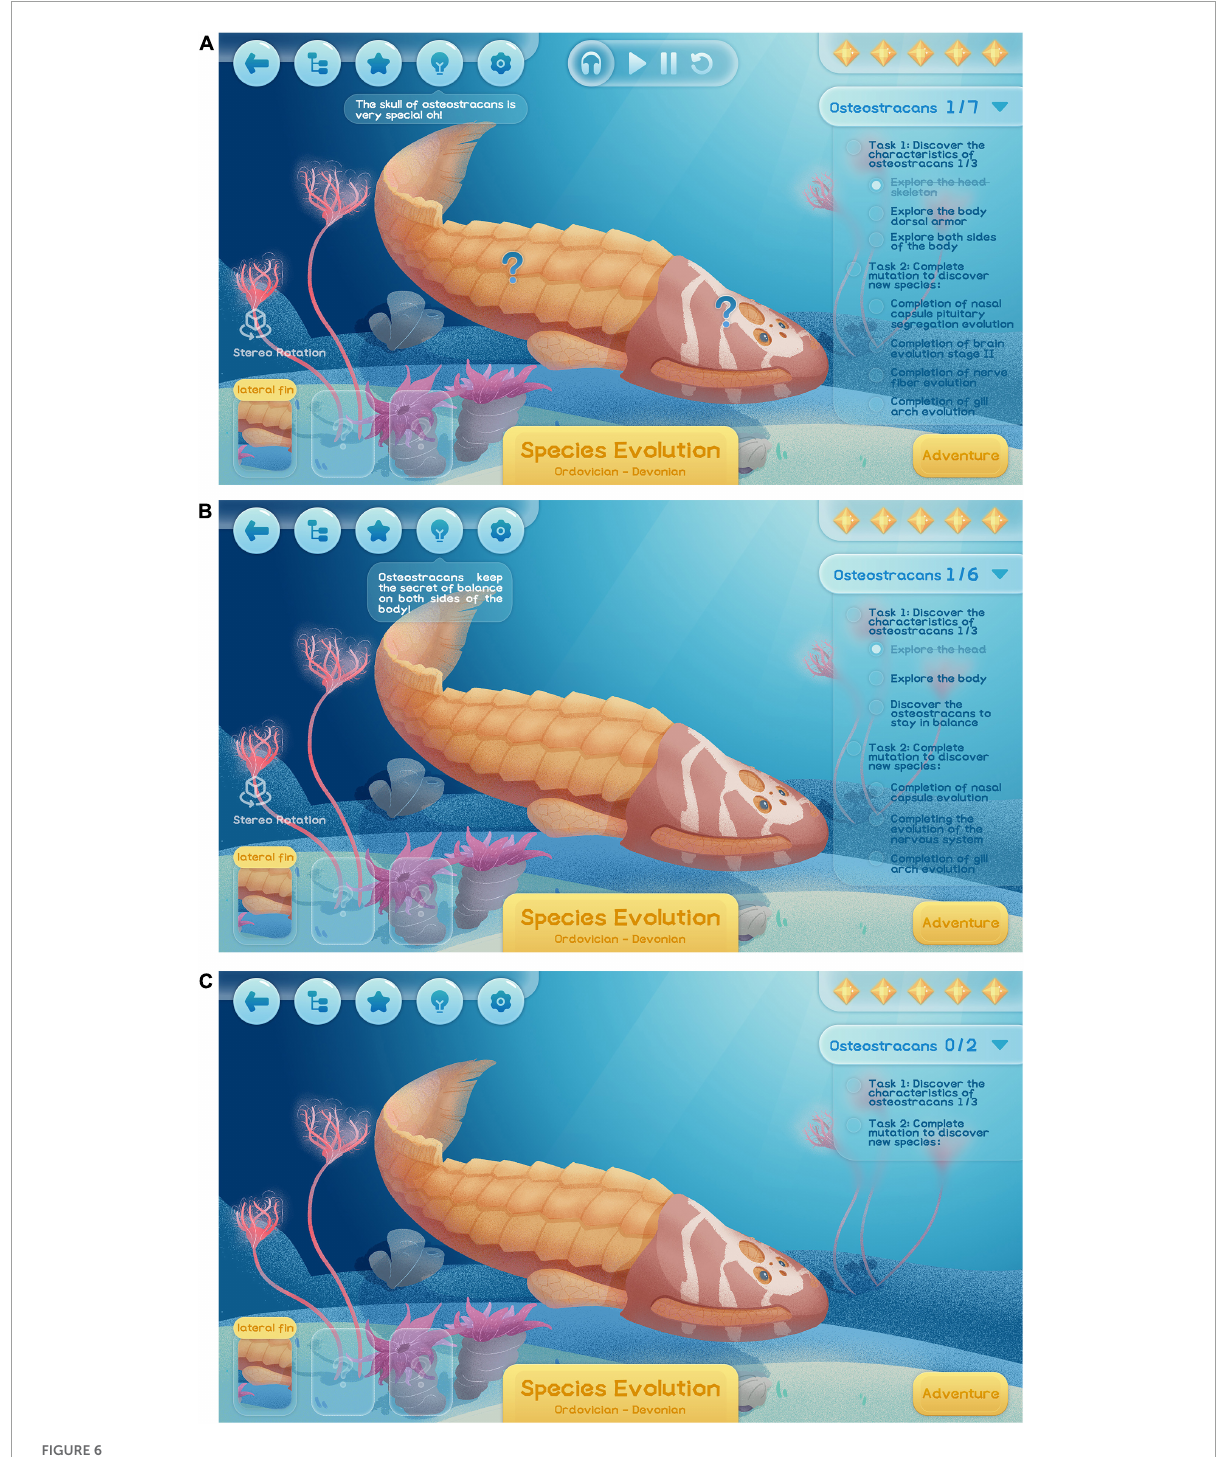
FIGURE6 Species feature extraction